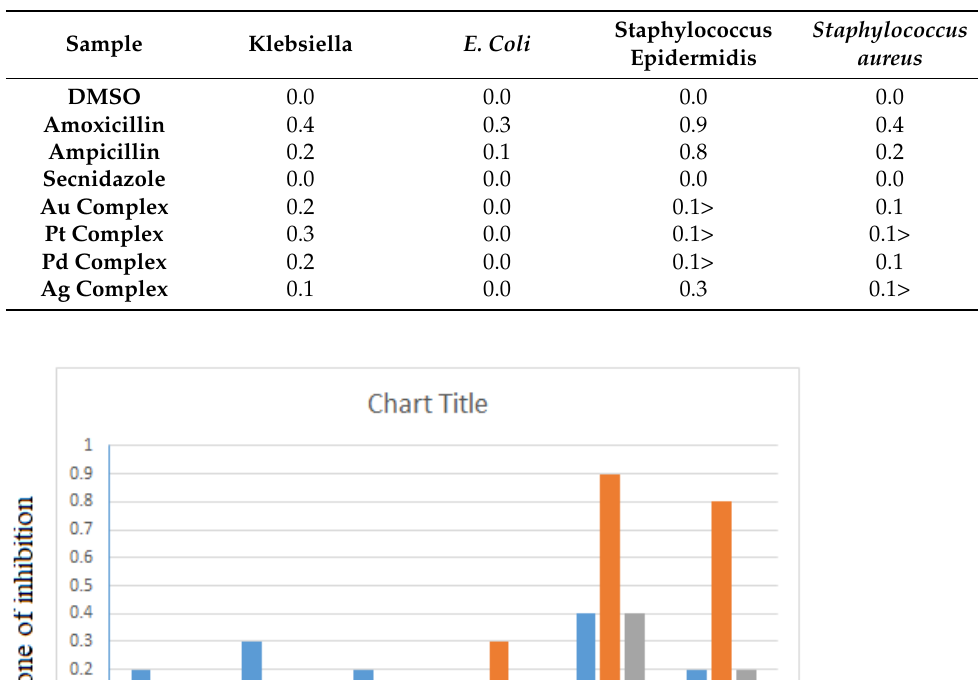
Table 4. Growth inhibition zone of the four synthesized complexes.